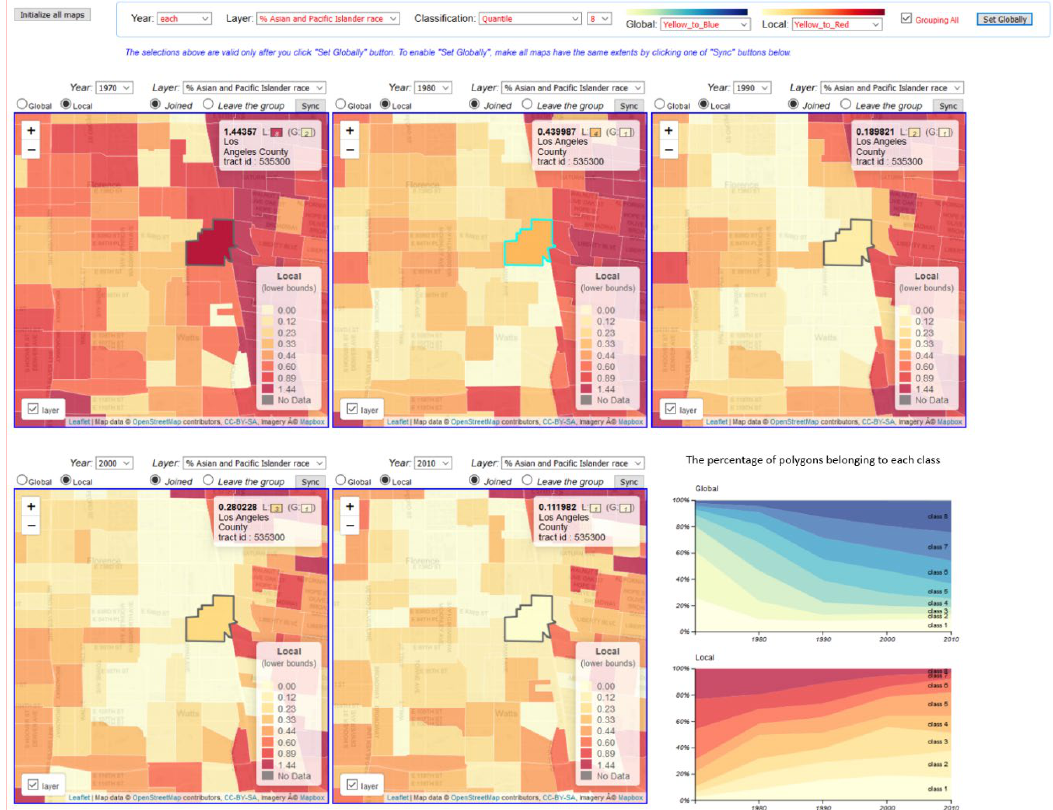
Figure 8. The percentage of Asians and Pacific Islanders in a zoomed-in area with local classification.